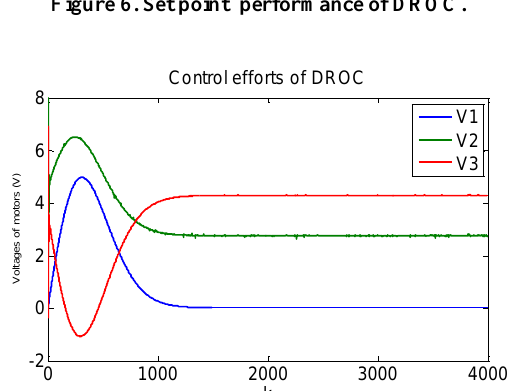
Figure 6. Set point performance of DROC.